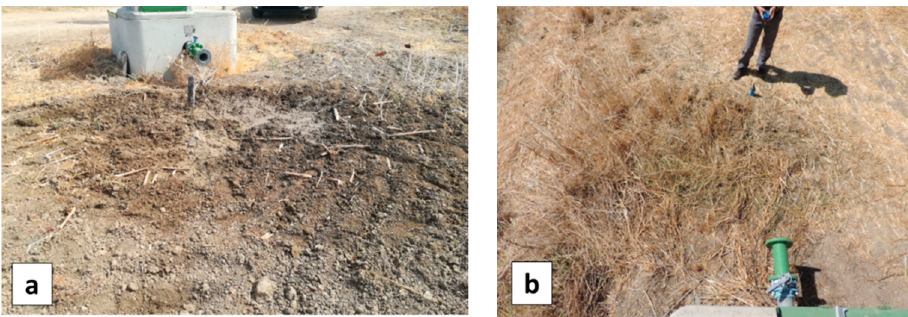
Figure 21. Artificial leaks in Ferreira district at ( a ) hydrant H9.7 (essentially bare soil) and ( b ) hydrant H16 (dry grass).